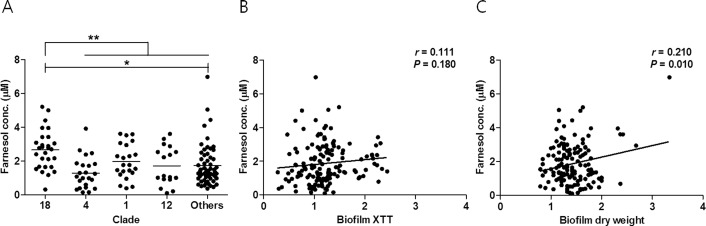
Secretion of E,E-farnesol (μM) of 149 bloodstream isolates of Candida albicans according to multilocus sequence typing clade (A) and their correlation of biofilm formation determined by measuring XTT activity reduction (B) and dry weight (C).Each symbol represents individual isolate. Horizontal lines indicate the mean farnesol values of the dataset at each clade. The biofilm results by both methods were normalized to those for C. albicans ATCC 90028 (set as 1.0). * Statistically significant (p < 0.05) compared among 5 different groups by one-way ANOVA. ** Statistically significant (p < 0.05) compared between clade 18 and total non-clade 18 by independent sample t-test.